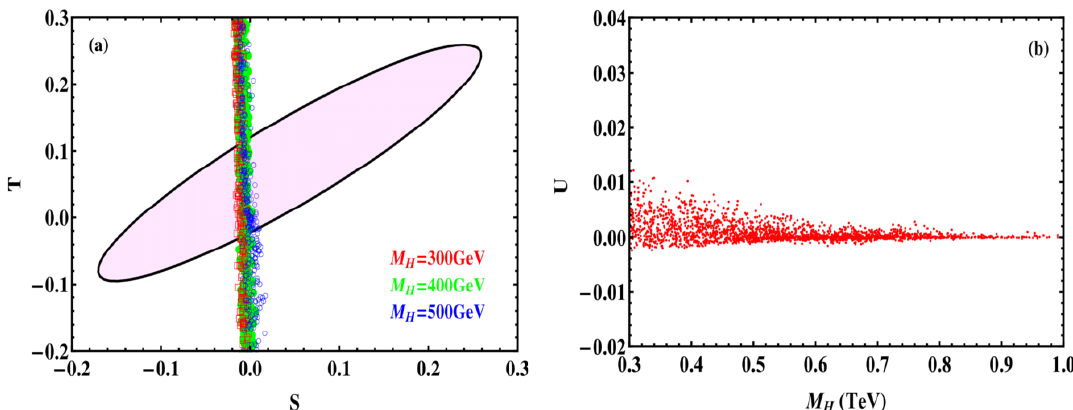
Figure 1 . Electroweak precision constraints on the 2HDM. Plot-(a) shows the S (cid:0) T con- tour at 95% C.L. (by setting U = 0), in comparison with the 2HDM predictions for M (300 ; 400 ; 500) GeV which correspond to (red, green, blue) dotted regions, respectively. Plot-(b) presents the 2HDM prediction for U parameter over the mass-range M